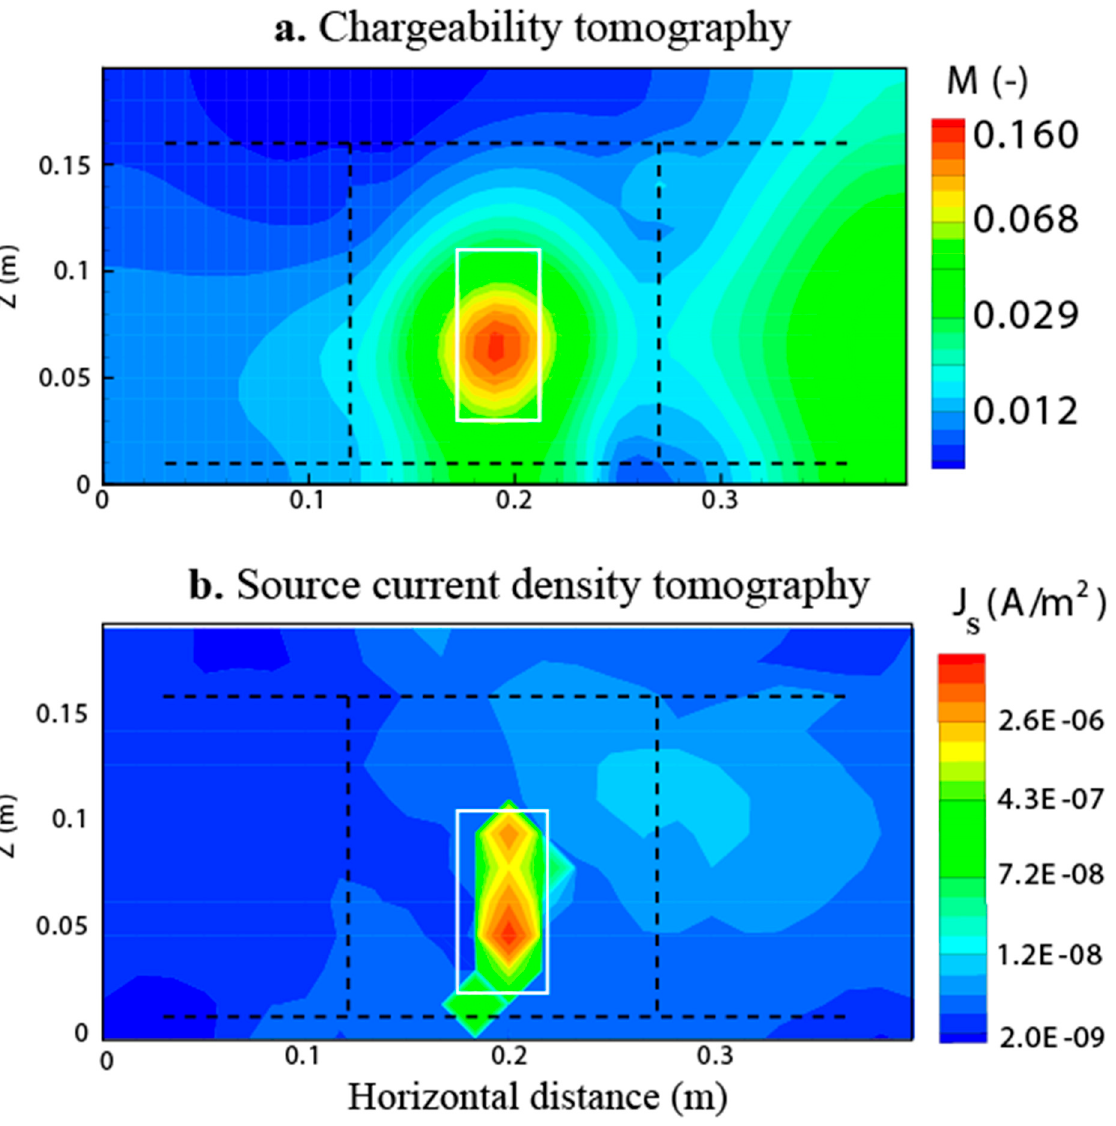
Figure 24. Use of induced polarization to localize an ore body in a sandbox. ( a ) Chargeability tomography from the classical Gauss–Newton inversion of the induced polarization data and using the setup shown in Figure 23. Inversion of the chargeability with 12 bipoles [A, B] (A and B are current electrodes). All the other electrodes are voltage electrodes M i with respect to a reference electrode N. These electrodes are used to measure the secondary voltages after shutting down the primary electrical current. ( b ) Inversion of the source ‐ current density ( J S ) with four bipoles [A, B]. The area encapsulated by the white line corresponds to the position of the target (pyrite grains mixed with sand). The black dash line shows the position of the array of electrodes as shown in Figure 24 (only four bipoles used for the source ‐ current ‐ density inversion). The white line underlines the area where the ore is truly located. Adapted from [100].